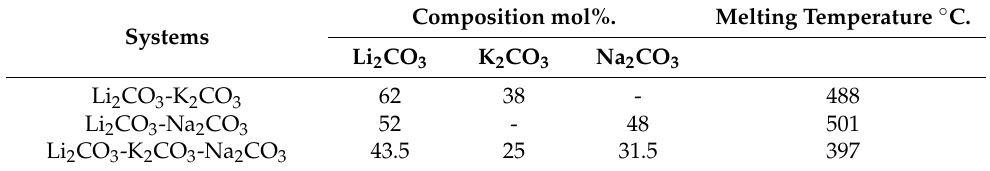
Table 1. Composition and melting temperature of binary and ternary alkali carbonate eutectics. Composition Systems